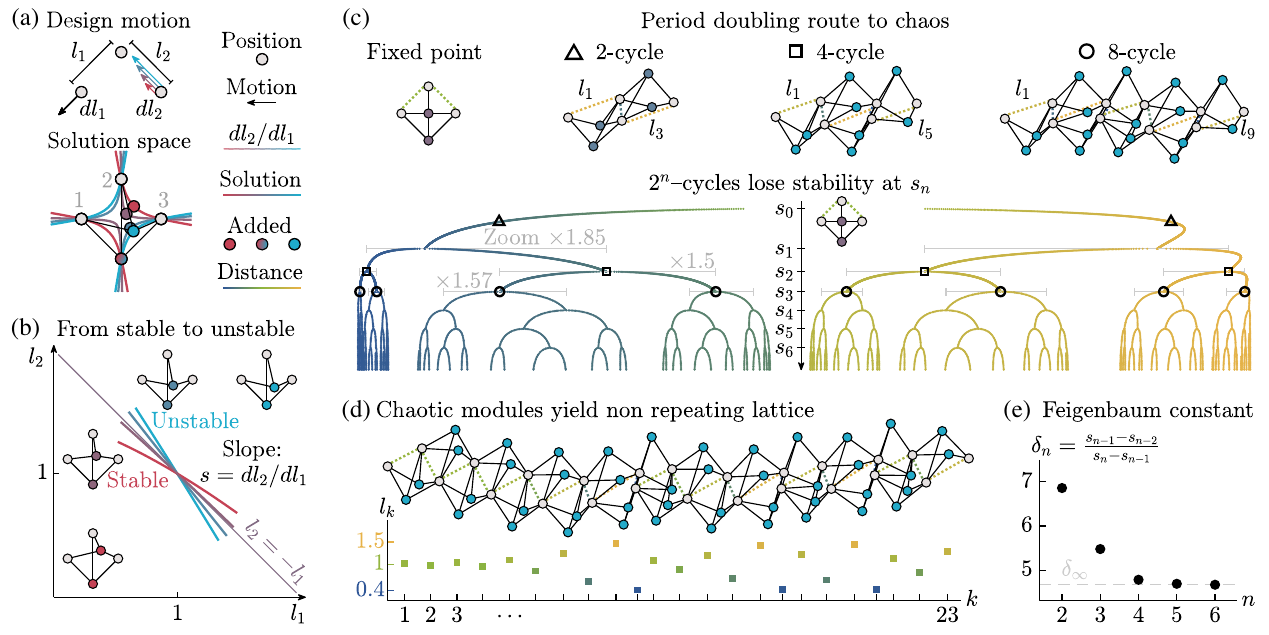
FIG. 12. Mechanical chaos. (a) Schematic of the stability design process at the fixed point l 1 ¼ l 2 ¼ 1 , with the designed instantaneous node motions in black and colored arrows, the corresponding solution spaces in colored lines, and the positions of the added nodes for each unit in colored nodes. (b) Slope plots of the conformational motion for each unit. (c) At a slope of s 0 ¼ − 1 (left), the fixed point l (cid:3) ¼ 1 is marginally stable. As the slope passes s 1 , the fixed point becomes unstable, and a new stable 2-cycle is born (triangle). As the slope continues past s n , each 2 n -cycle becomes unstable and gives birth to a stable 2 n þ 1 -cycle, until (d) the unit becomes chaotic with no stable cycles. (e) The ratio of slopes at the bifurcations converges to the Feigenbaum constant. The slope values in this example are ð s 0 ; s 1 ; s 2 ; s 3 ; s 4 ; s 5 ; s 6 ; s 7 Þ ≈ ð − 1 ; − 1 . 522545 ; − 1 . 574527 ; − 1 . 582104 ; − 1 . 583487 ; − 1 . 583777 ; − 1 . 583838 ; − 1 . 583851 Þ